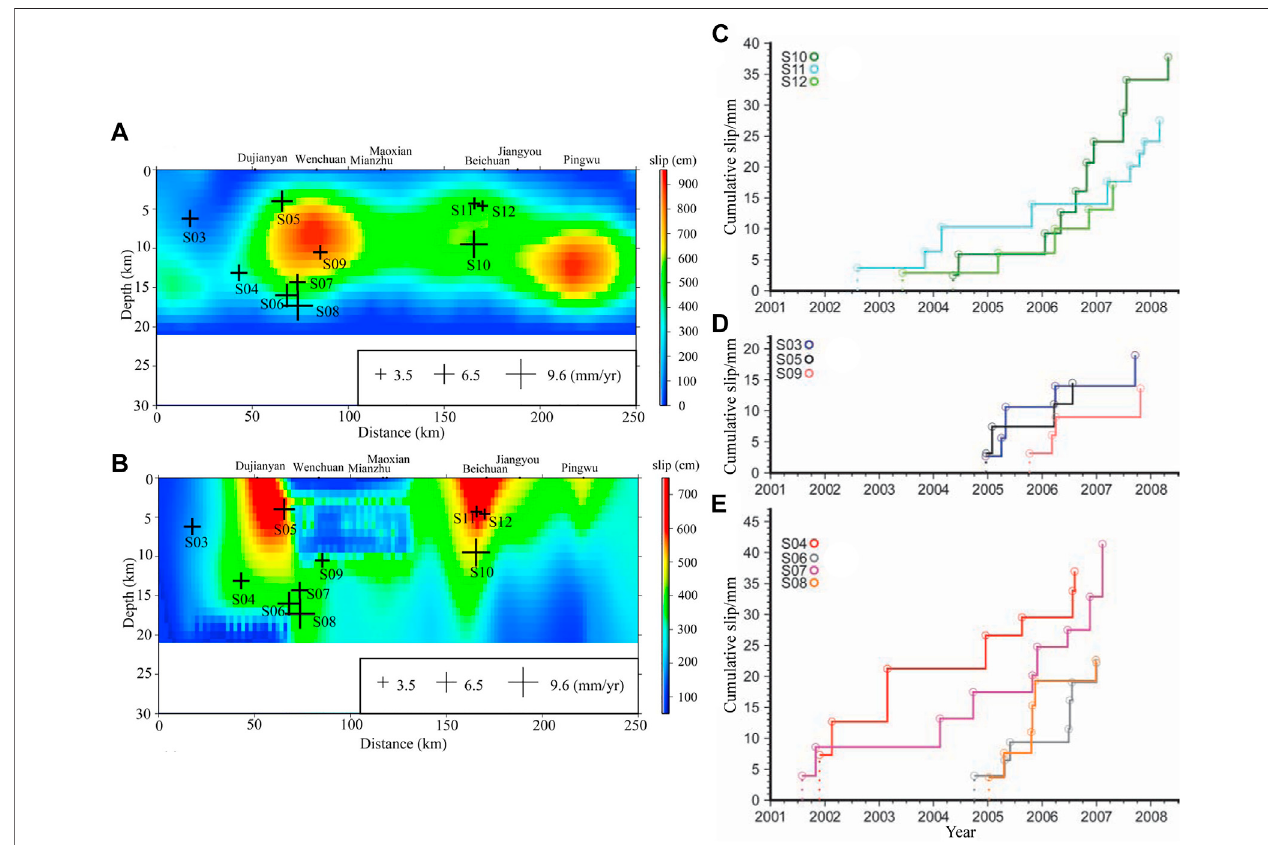
FIGURE6| Estimatedslipratesshowntogetherwith (A) coseismicslipinvertedfromteleseismicwaveformdataand (B) coseismicslipinvertedfromgeodeticdata. (C – E) Cumulative slip calculated from the 10 repeating earthquake sequences in the Longmenshan fault zone (LFZ). The sizes of the crosses in (A) and (B) are proportional to the slip rate (Li et al., 2011; Chen and Li,